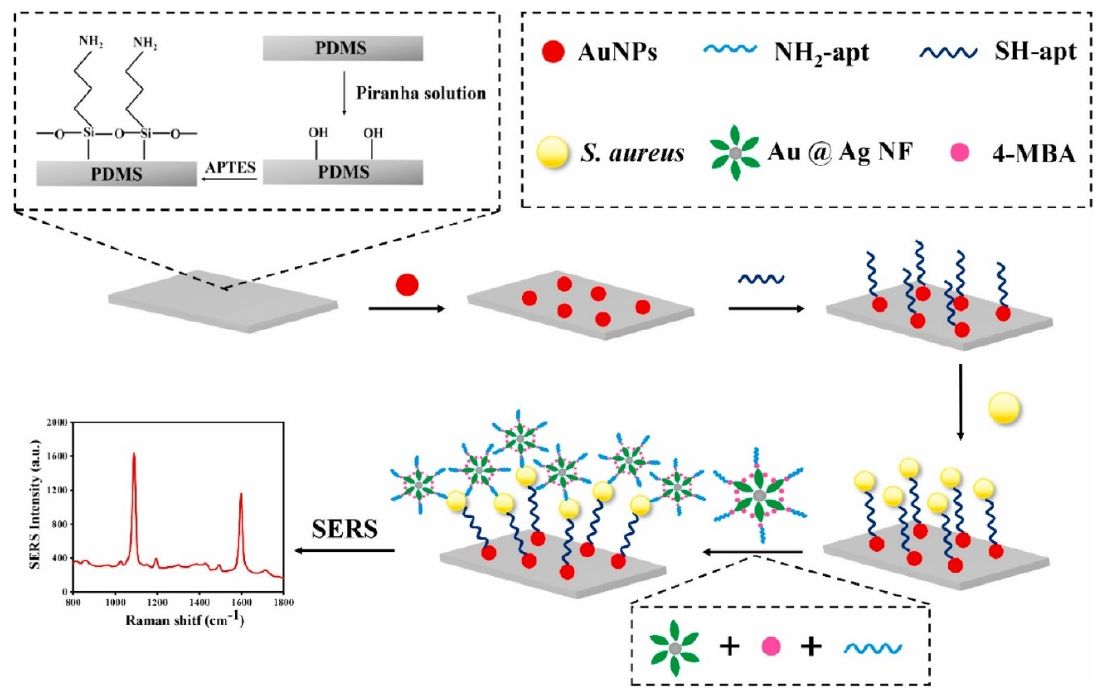
Figure 11. Schematic representation of the developed SERS aptasensor. Reproduced with permission from [86]. Copyright 2020 Elsevier B.V.